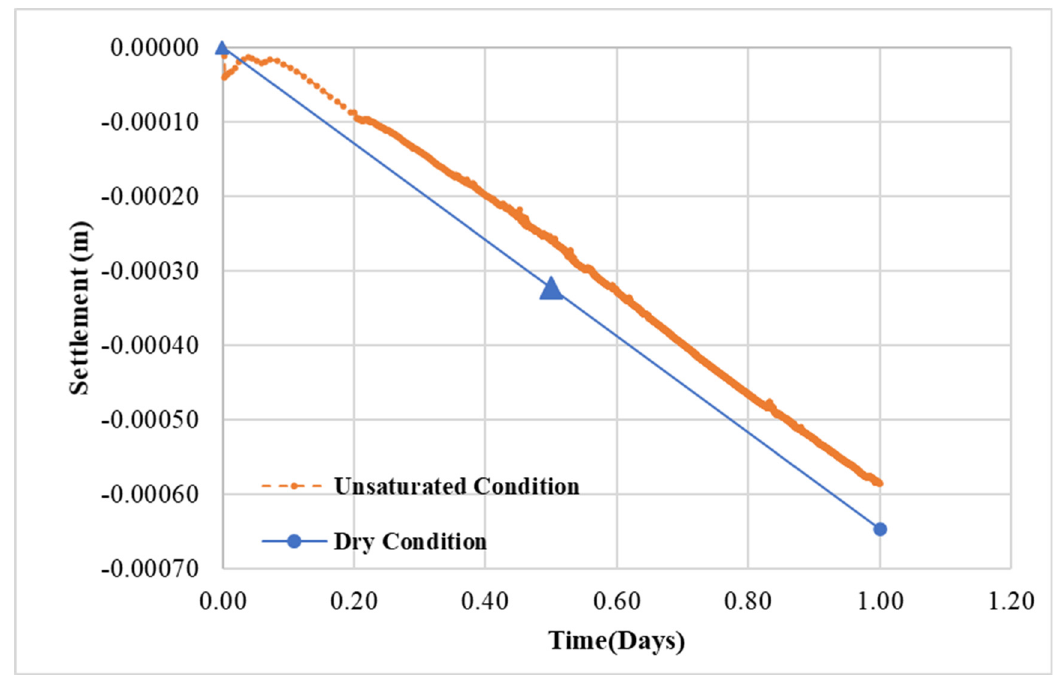
Figure 11. Effect of the degree of saturation (DOS).